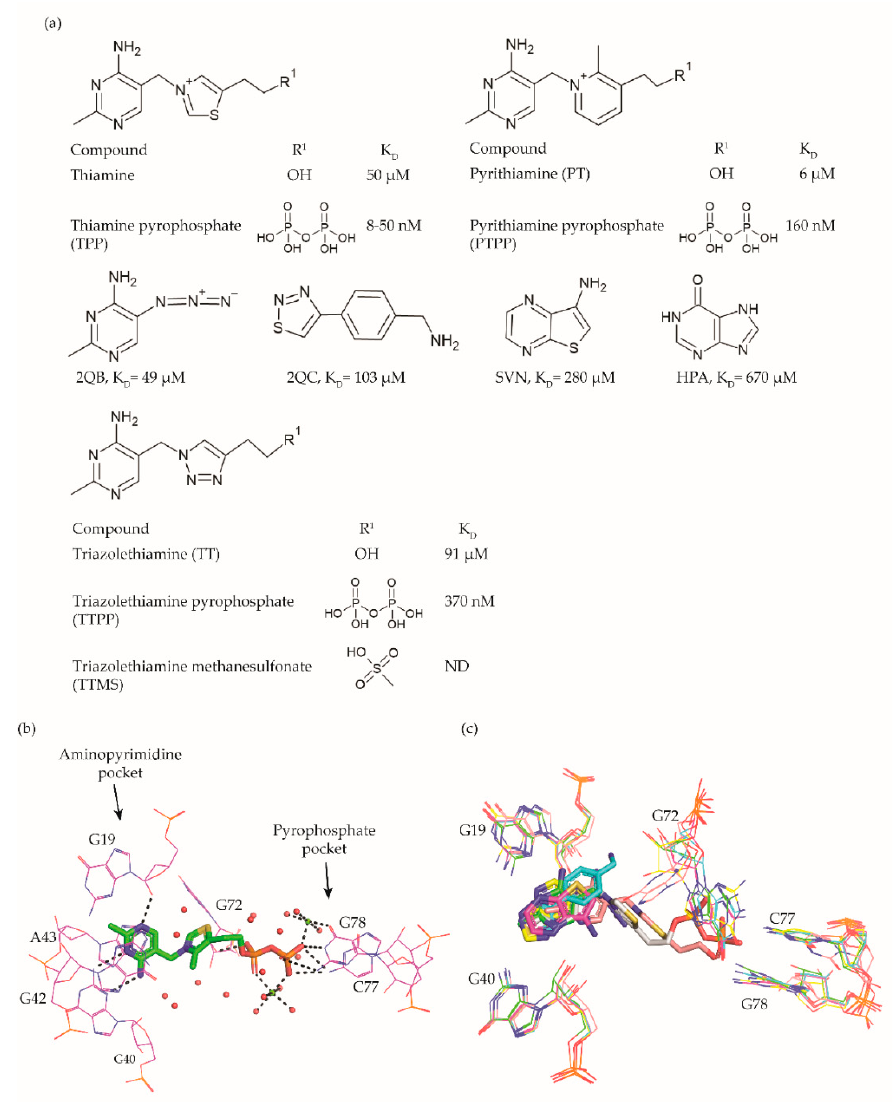
Figure 2. TPP riboswitch ligands. ( a ) Chemical structures and binding affinities of ligands taken from various studies [32,45,52,53]. ( b ) The binding pocket of the TPP riboswitch in complex with TPP (Protein Databank (PDB) ID: 2GDI). The aminopyrimidine and pyrophosphate binding pockets are labelled. Water molecules are shown as red spheres, magnesium ions as green spheres, and hydrogen bonds as dotted lines. The negative charge on TPP is compensated by magnesium ions through direct and indirect hydrogen bonds with the surrounding residues. ( c ) Superposition of TPP riboswitch binding pocket in complex with different fragments (PDB ID: 4NYA (green), 4NYB (cyan), 4NYC (magenta), 4NYD (yellow), 4NYG (pink) and 2GDI (grey)). The conformational flexibility of G72 is visible.